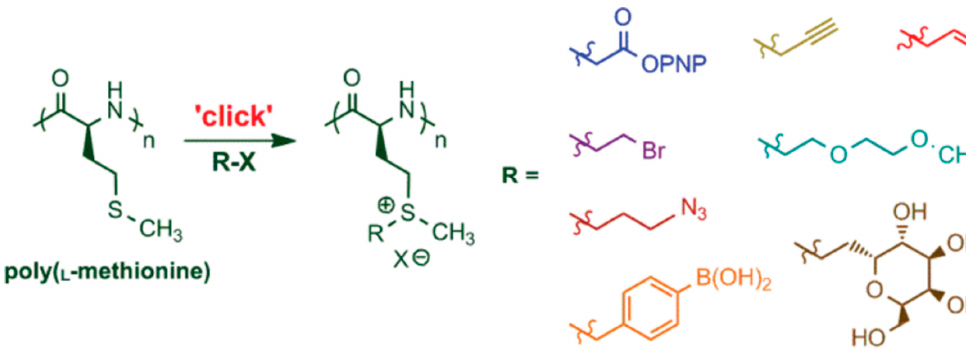
Figure 21. Preparation of Multifunctional and Multireactive Polypeptides via Methionine Alkylation. Reproduced with permission from reference [90].